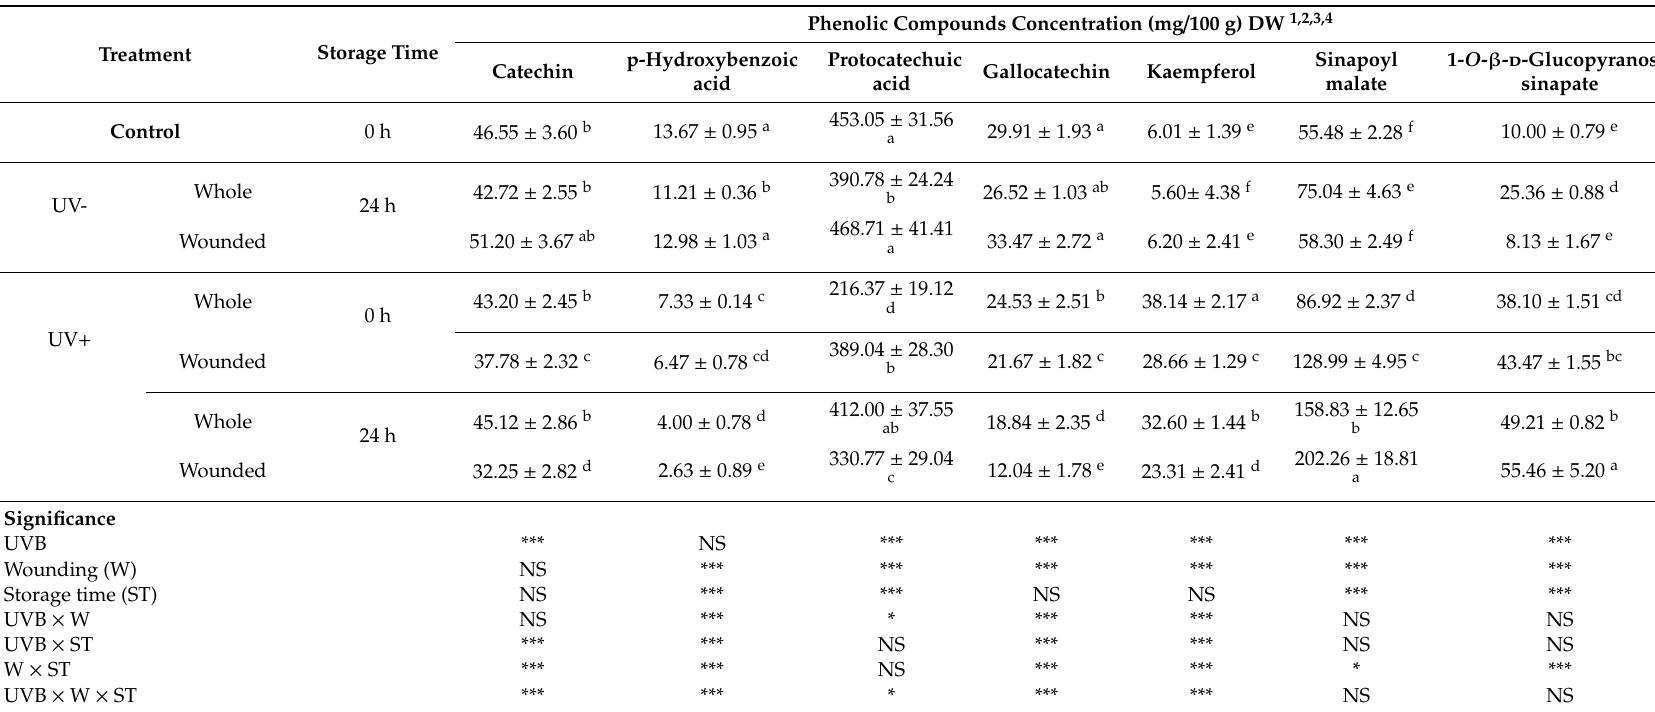
Table 2. Concentration of individual phenolic compounds before and after storage (24 h at 16 ◦ C) of whole and wounded red prickly pear peel treated with UVB